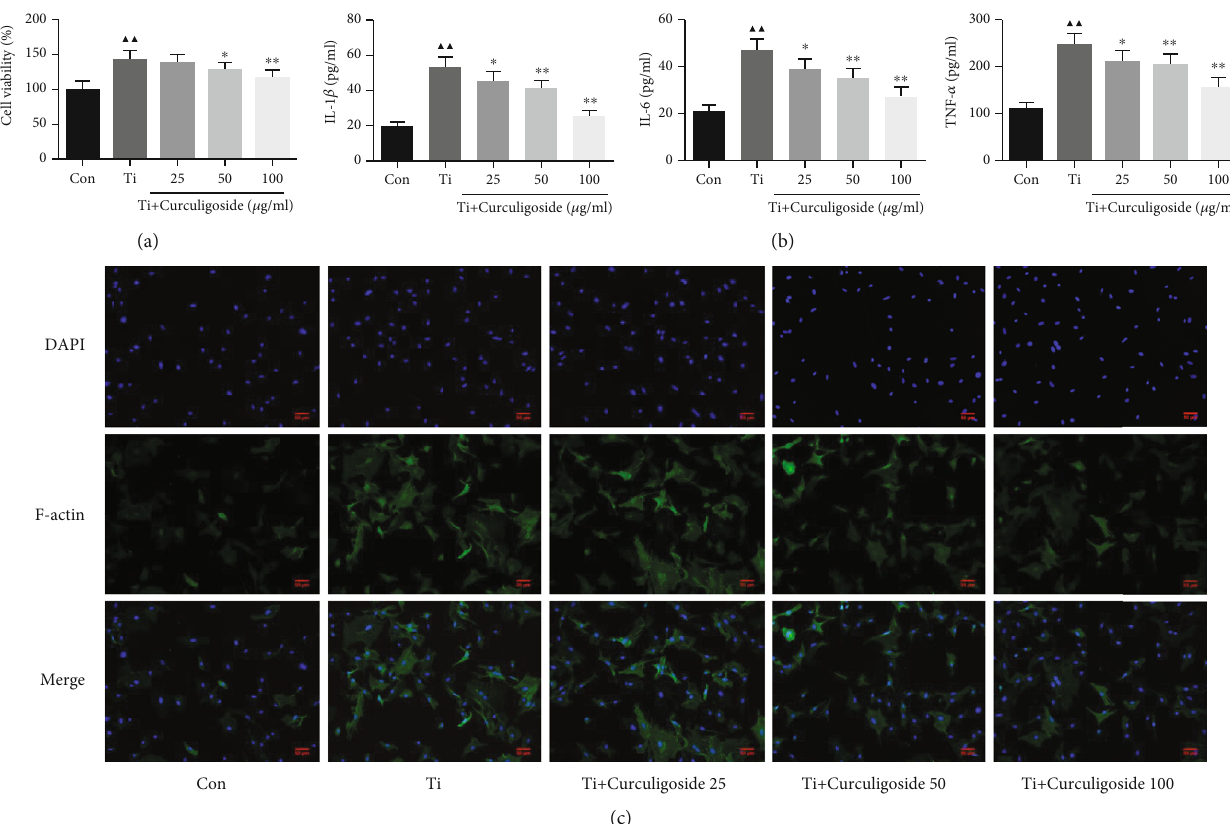
Figure 5: Curculigoside treatment inhibited Ti-induced activation of osteoclast activity in BMSCs. (a) After being intervened with Ti and treated with curculigoside at di ff erent concentrations (25, 50, and 100 μ g/ml) for 48h, BMSC viability was detected by the CCK-8 assay ( n = 6 ). (b) The levels of TNF- α , IL-1 β , and IL-6 in BMSCs were detected using ELISA kits. (c) Cellular immuno fl uorescence of F-actin in BMSCs ( n = 3 ); results are represented as the mean ± SD . ▲ P < 0 : 05 , compared to the Con group; ▲▲ P < 0 : 01 , compared to the Con group; ∗ P < 0 : 05 , compared to the Ti group; ∗∗ P < 0 : 01 , compared to the Ti group. BMSCs: bone marrow stromal cells; Ti: titanium particles; Con: